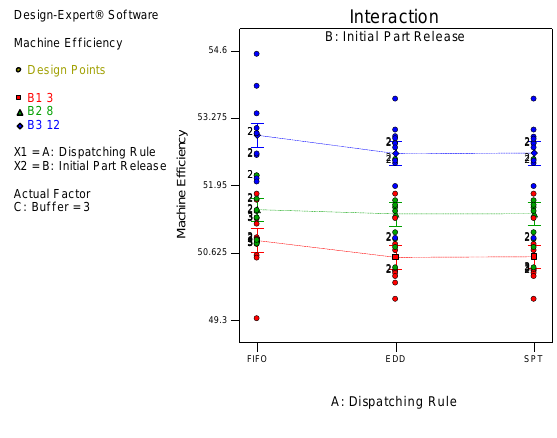
Figure 14. Machine efficiency initial part release & dispatching rule